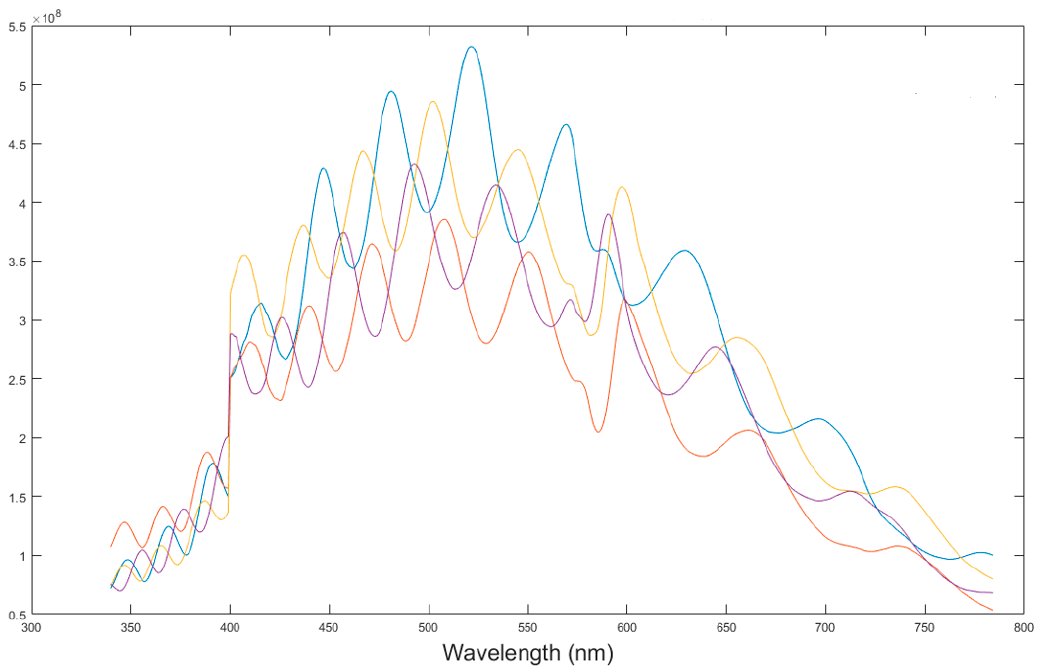
Figure 8. Spectral correction curve used to correct raw spectra. Here is the example of the correction curve for the diffuse reflectance configuration, i.e., no filter in the filter wheel and for each SDS: blue curve for SDS1, red curve for SDS2, yellow curve for SDS3 and purple curve for SDS4.